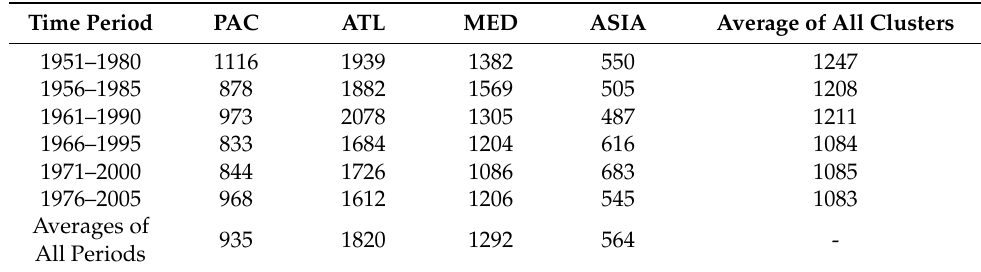
Table 4. Average geographical distances (km) between the poles of the two cluster ACs for all GCMs for all time periods in case of the clusters PAC, ATL, MED, and